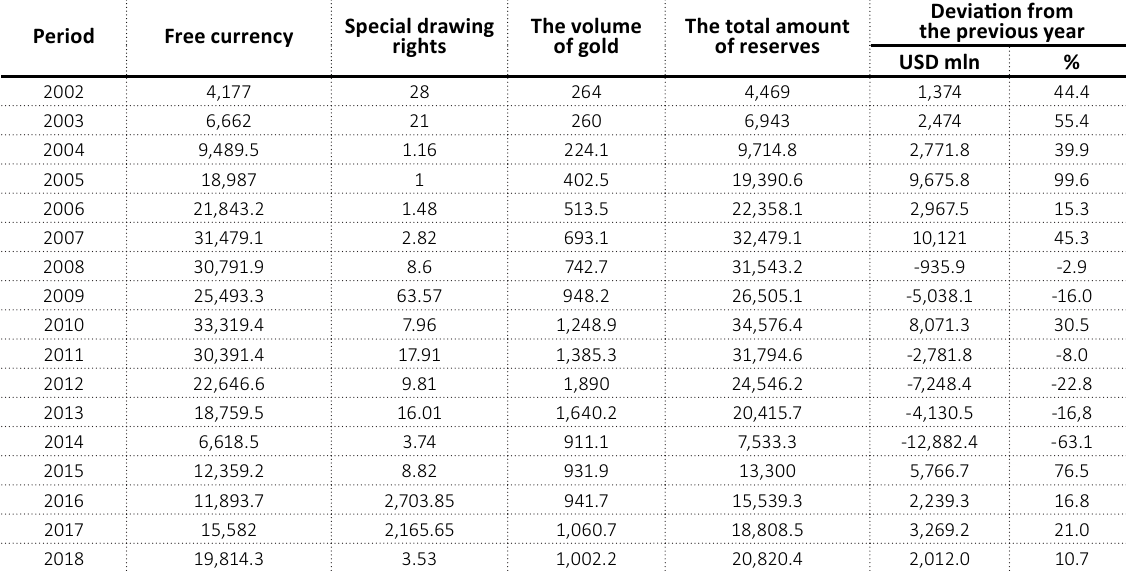
Table 8. Dynamics of gold and foreign exchange reserves in Ukraine, UAH